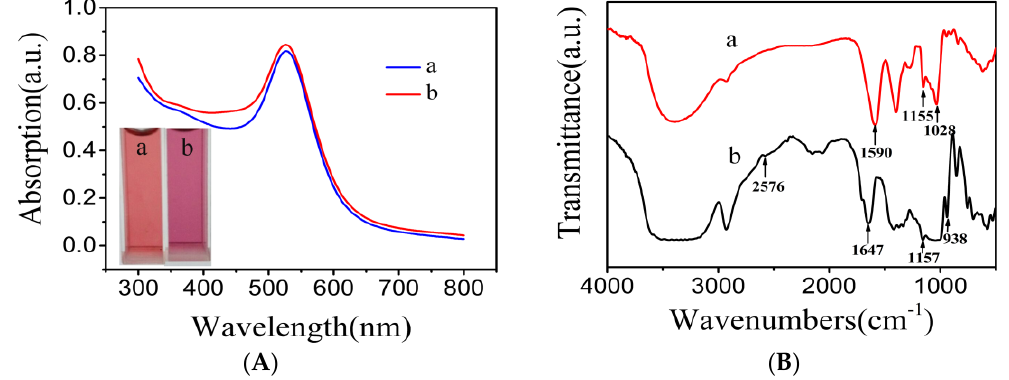
Figure 1. (A) UV-Vis spectra of the β-CD@AuNPs (a) and AuNPs (b); (B) FT-IR spectra of the β- CD@AuNPs (a) and SH-β-CD (b).